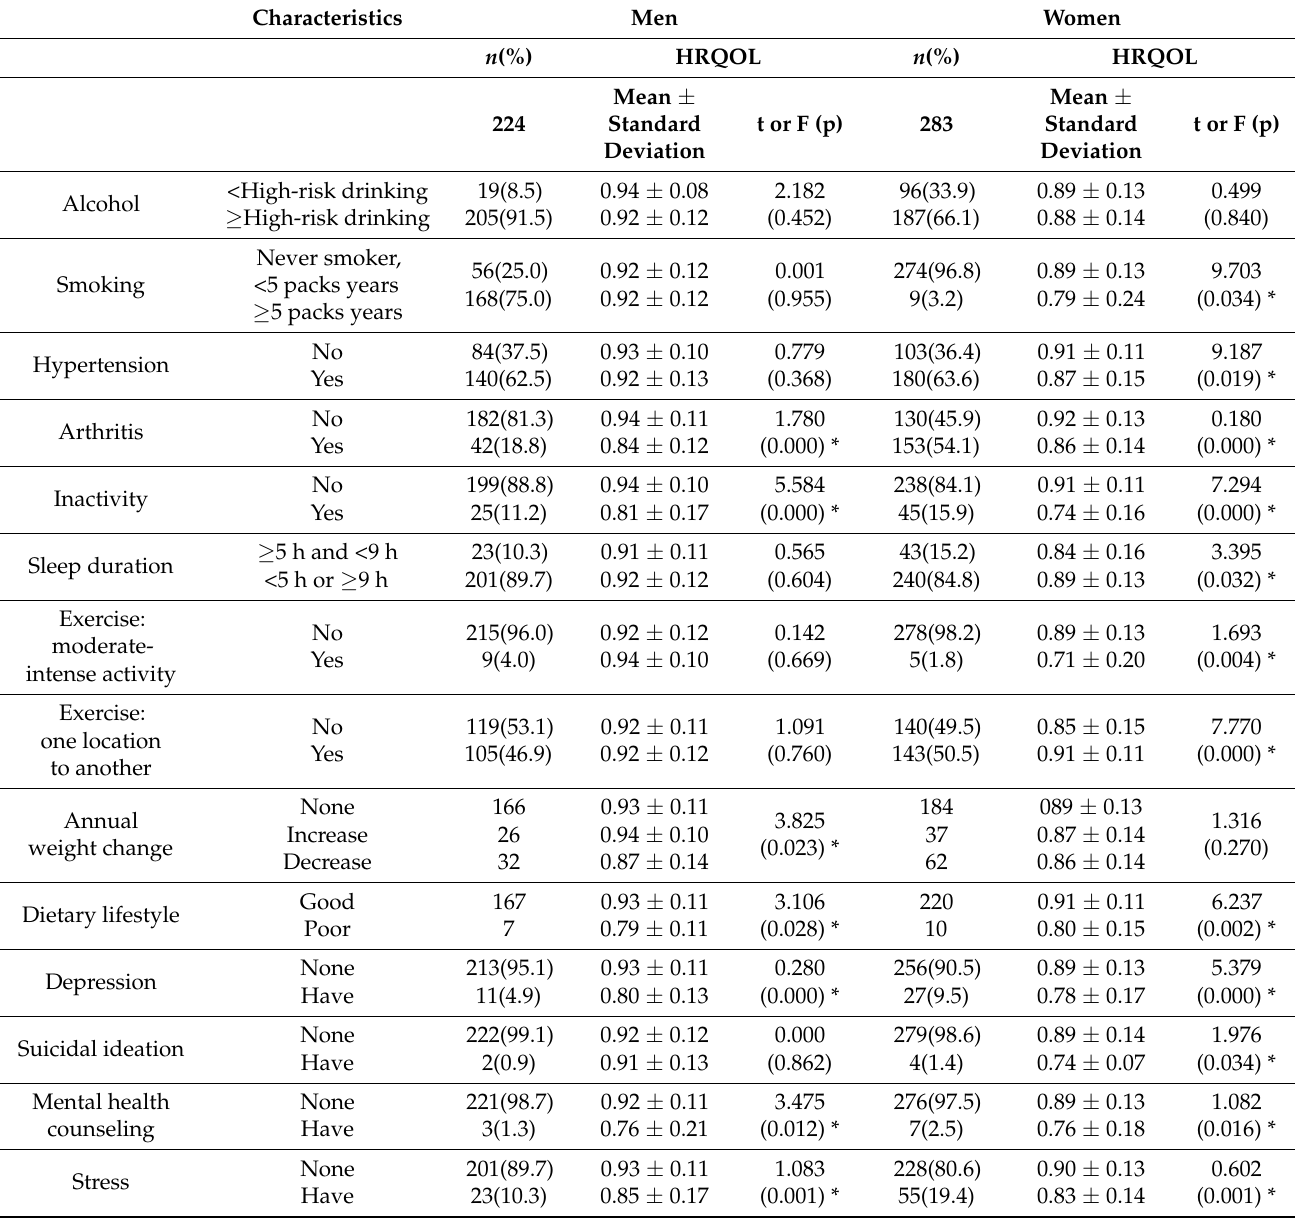
Table 2. Difference in health-related quality of life by lifestyle